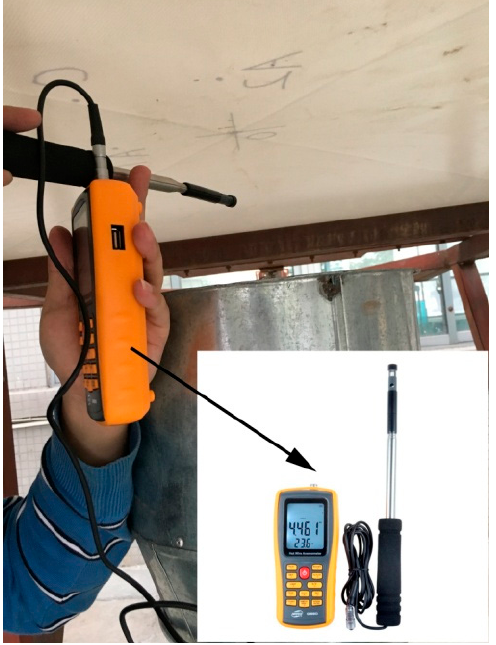
Figure 6. Digital velocity measurement.